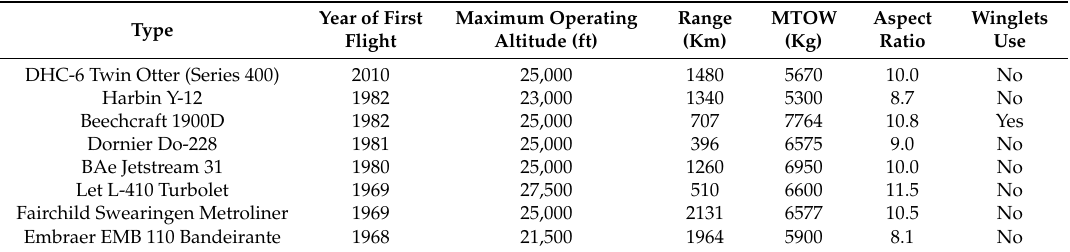
Table 1. Overview of regional turboprop aircraft (19 passengers capacity). (Data sourced from the respective aircraft manufacturer brochures, not an exhaustive list of all operating types). MTOW: maximum take-o ff